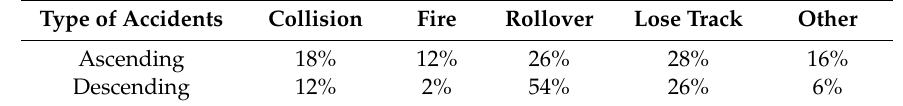
Table 5. Type of accidents.